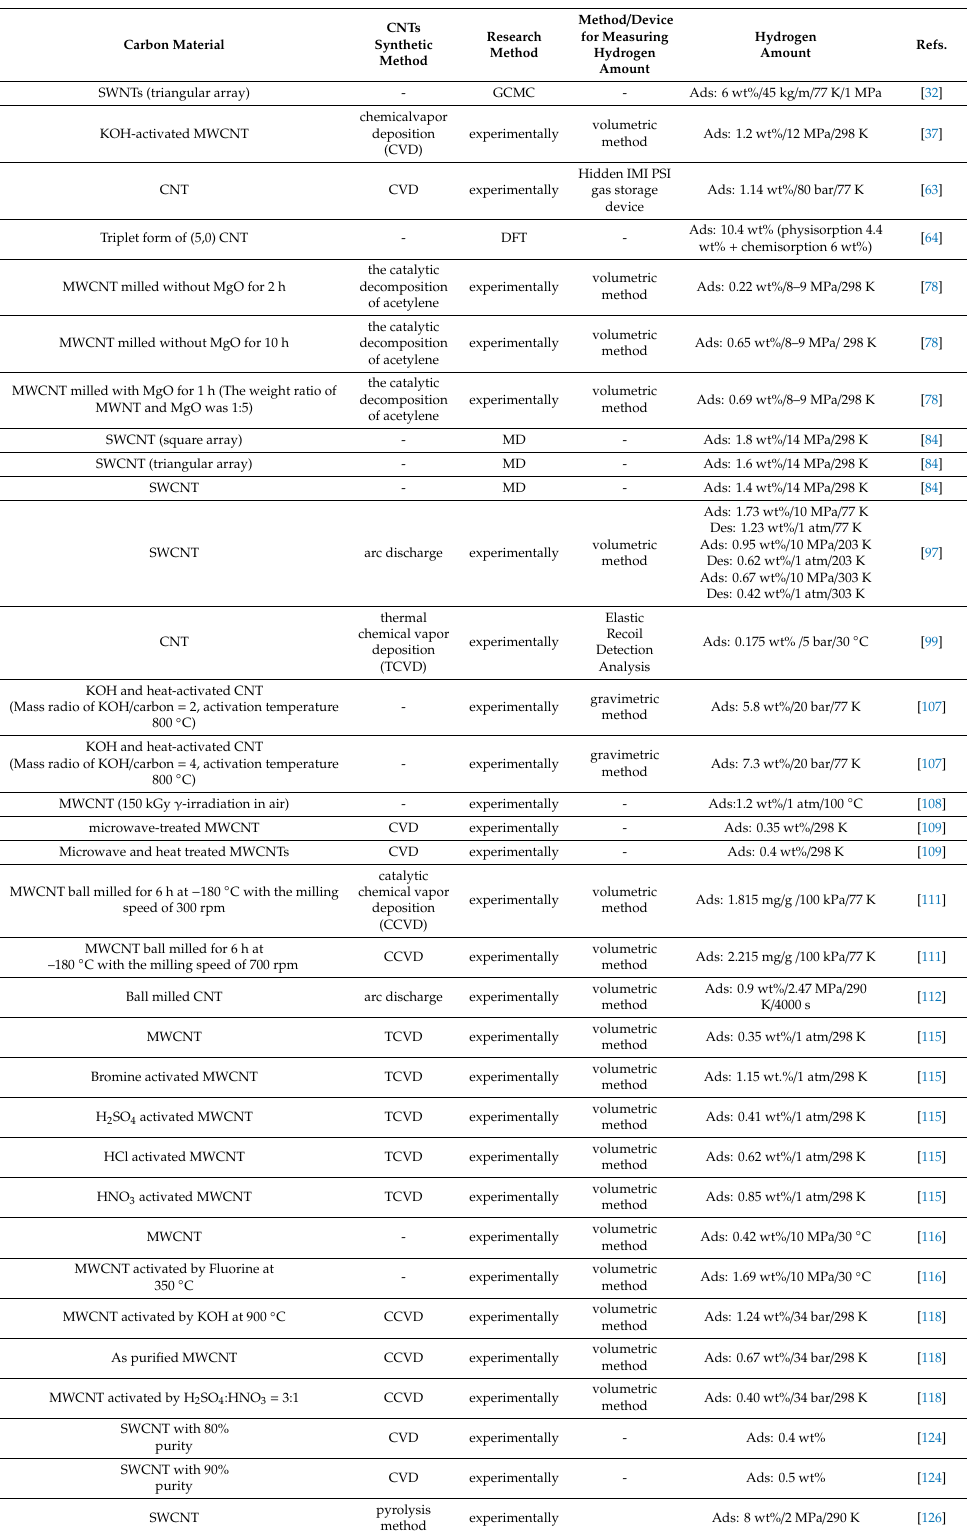
Table 1. Hydrogen storage properties of carbon nanotubes (CNTs) modified by physical and chemical